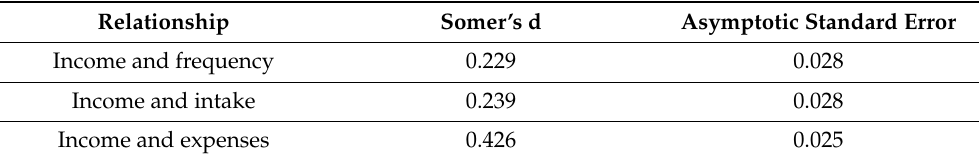
Table 6. Summary of Somers’ d values for monthly income.